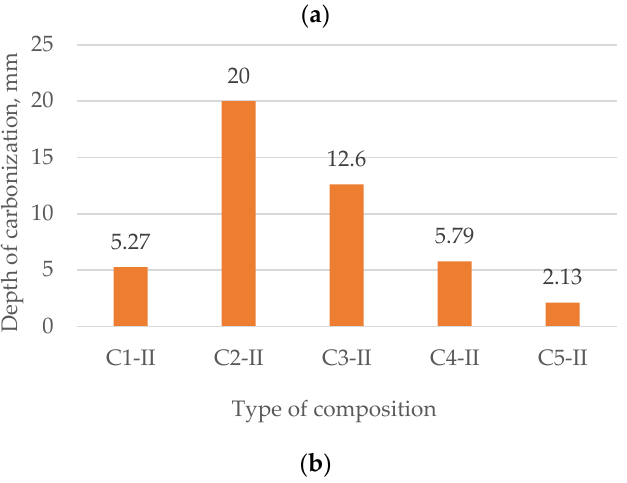
Figure 3. Evaluation of corrosion resistance of samples of the second line of research: ( a ) corrosion resistance of samples in liquid media; ( b ) the depth of concrete carbonization.